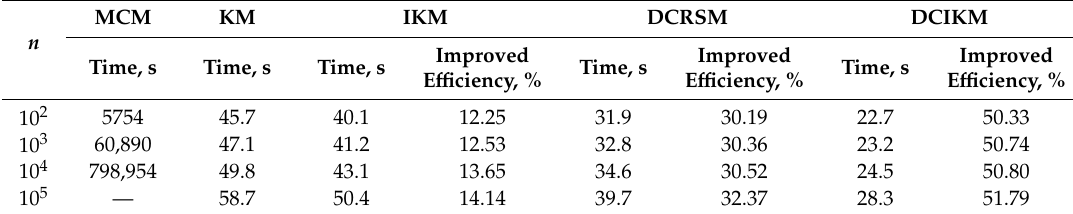
Table 4. Comparison of computing time for reliability analyses of five methods.